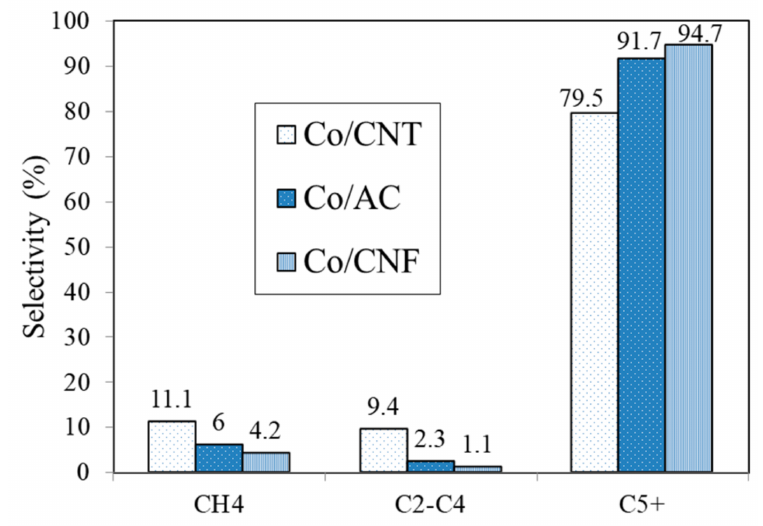
Figure 11. Product selectivity of different catalysts.